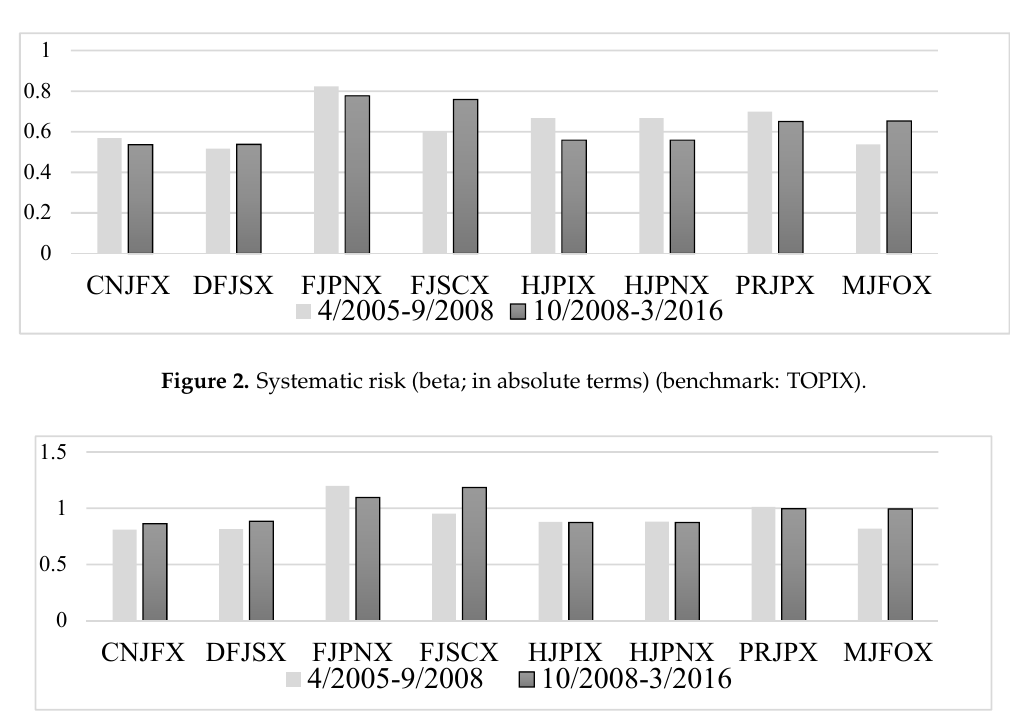
Figure 3 . Systematic risk (beta; in absolute terms) (benchmark: Mkt).